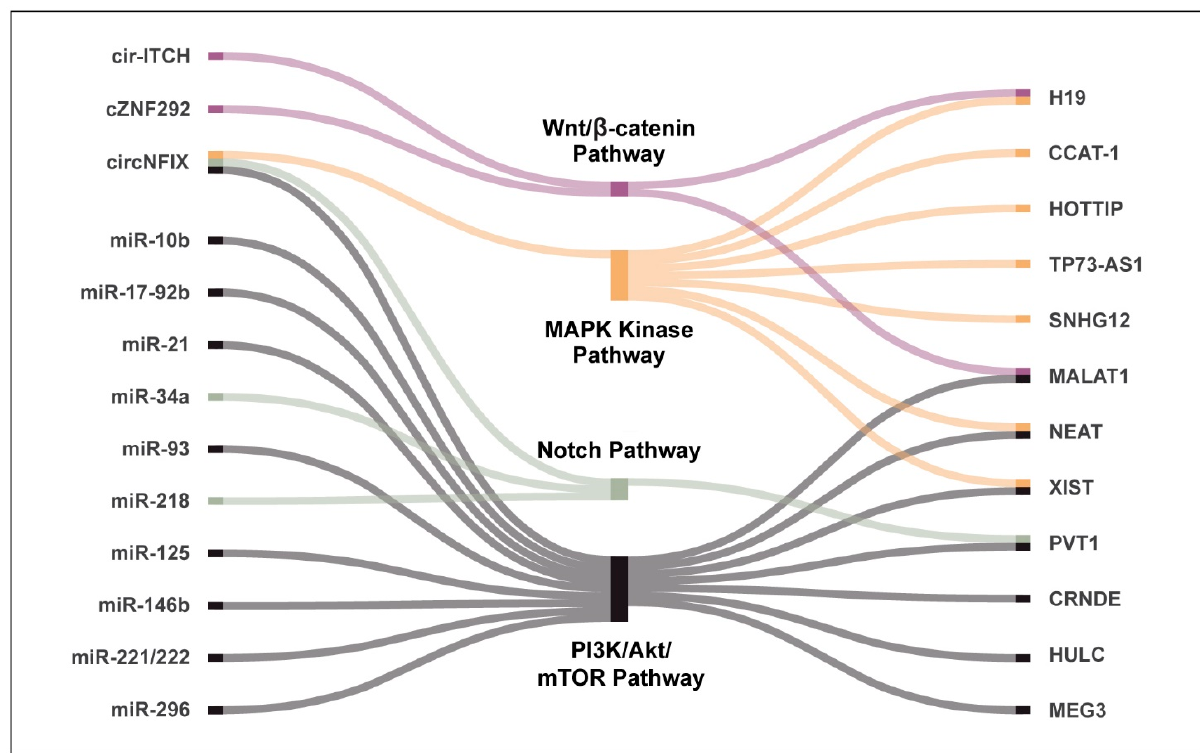
Figure 3. NcRNAs and key GBM pathways . Noncoding RNAs can interact with or engage in crosstalk with several key pathways that are dysregulated in gliomas including the PI3K/Akt/mTOR pathway, Notch signaling, and Wnt/ β -catenin pathway.